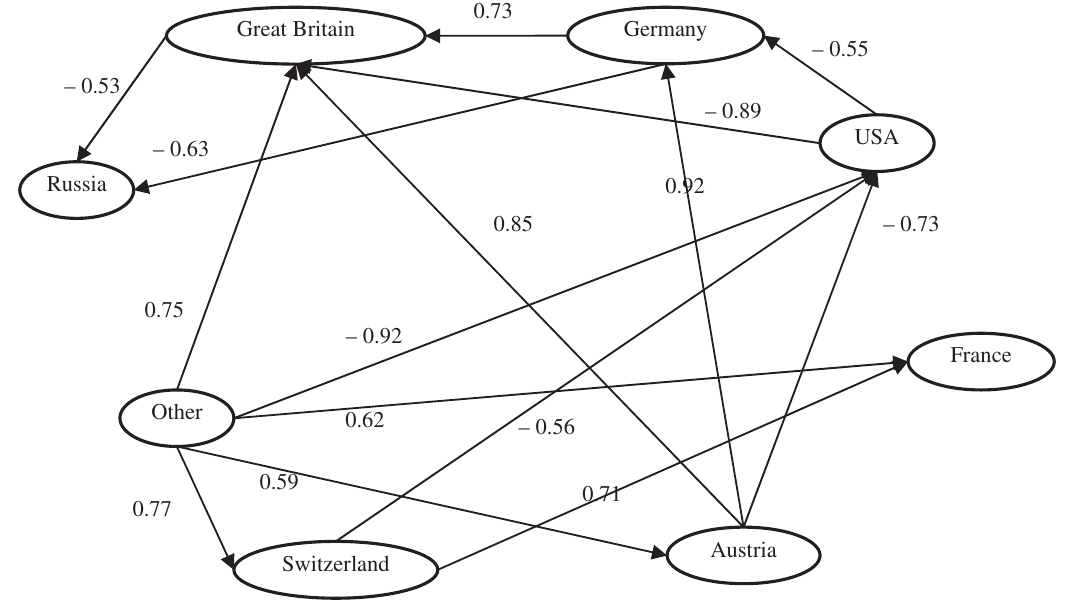
Fig. 1. The scheme of relationships of reinsurance operations of insurance (reinsurance) companies around the